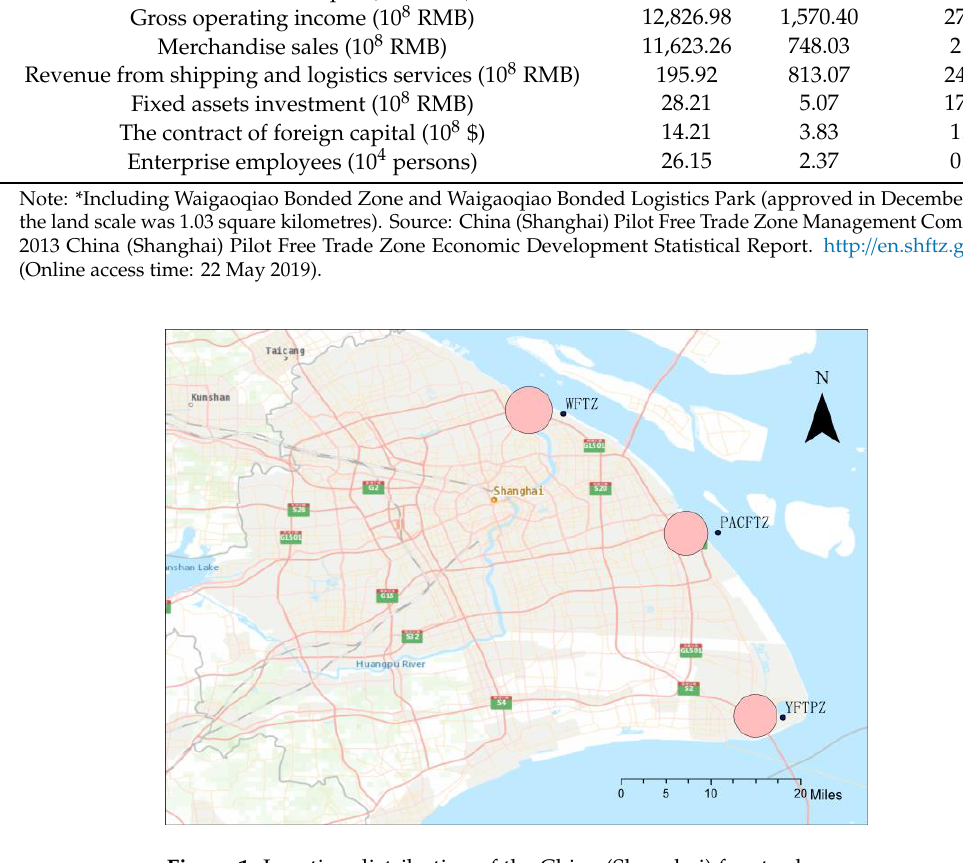
Figure 1. Location distribution of the China (Shanghai) free trade zone.